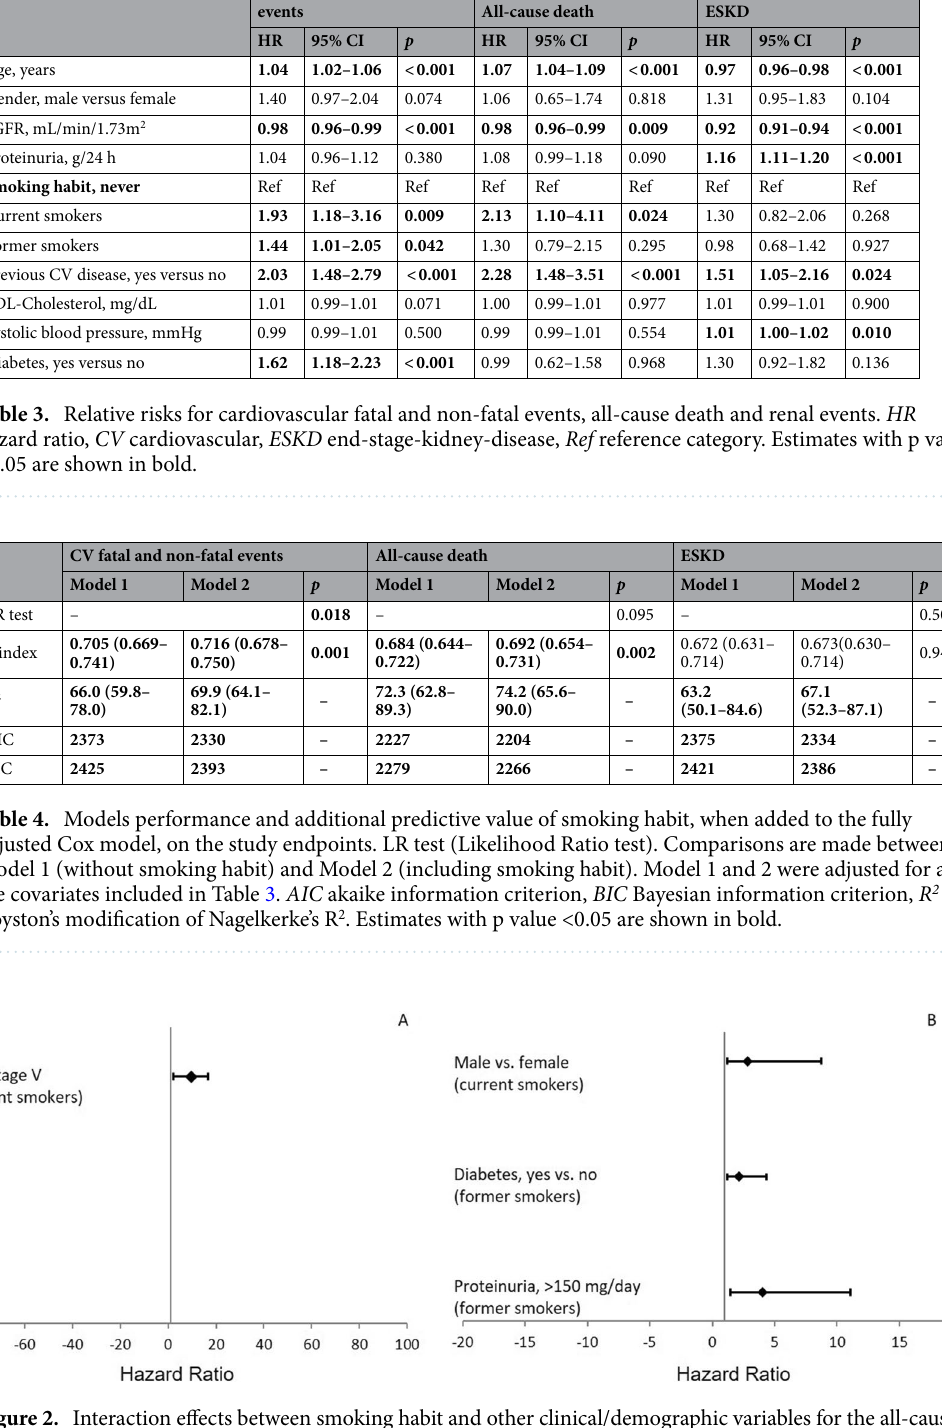
negative interaction between smoking habit and eGFR. After stratifying eGFR levels according to CKD stages, we detected a significant positive interaction between current smokers and CKD Stage V ( β = 2.27, p = 0.039) for the risk of all-cause death, between former smokers and proteinuria > 150 mg/day ( β = 1.39, p = 0.007) and the presence of type II diabetes ( β = 0.75, p = 0.041) for the risk of ESKD/50% eGFR decline. Moreover, being a current smoker modified the association between gender and renal outcome with a higher risk in male versus female patients ( β = 1.03, p = 0.044). Hazard Ratios of the effect modifications are depicted in Fig. 2.